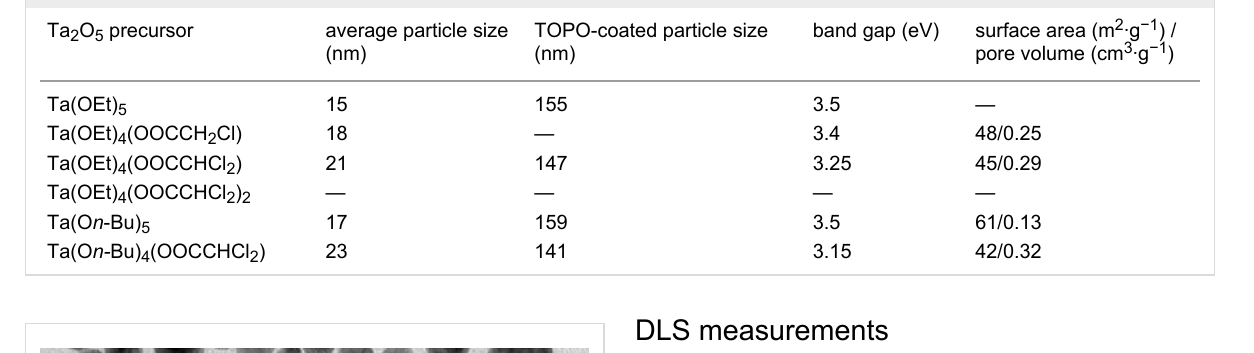
Table 2: Properties of Ta 2 O 5 nanoparticles.